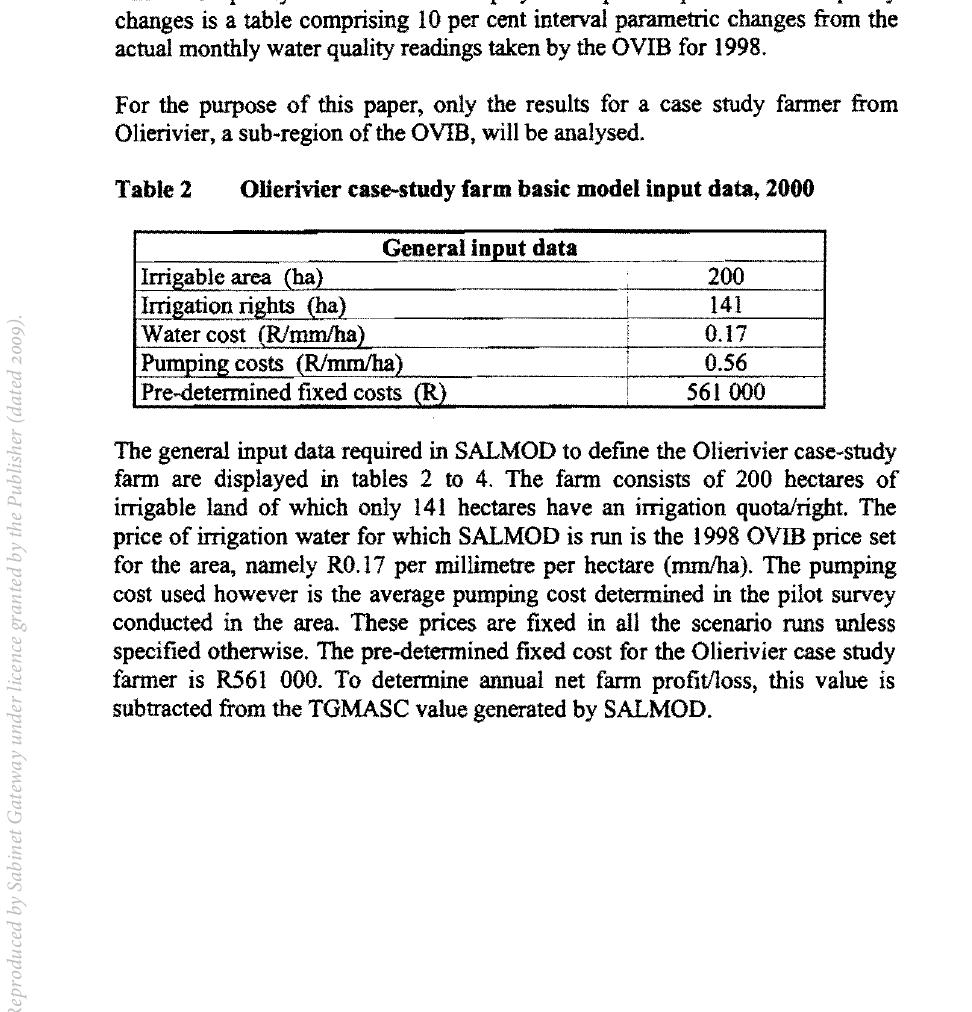
Olierivier case-study farm basic model input data, 2000 General in~ut